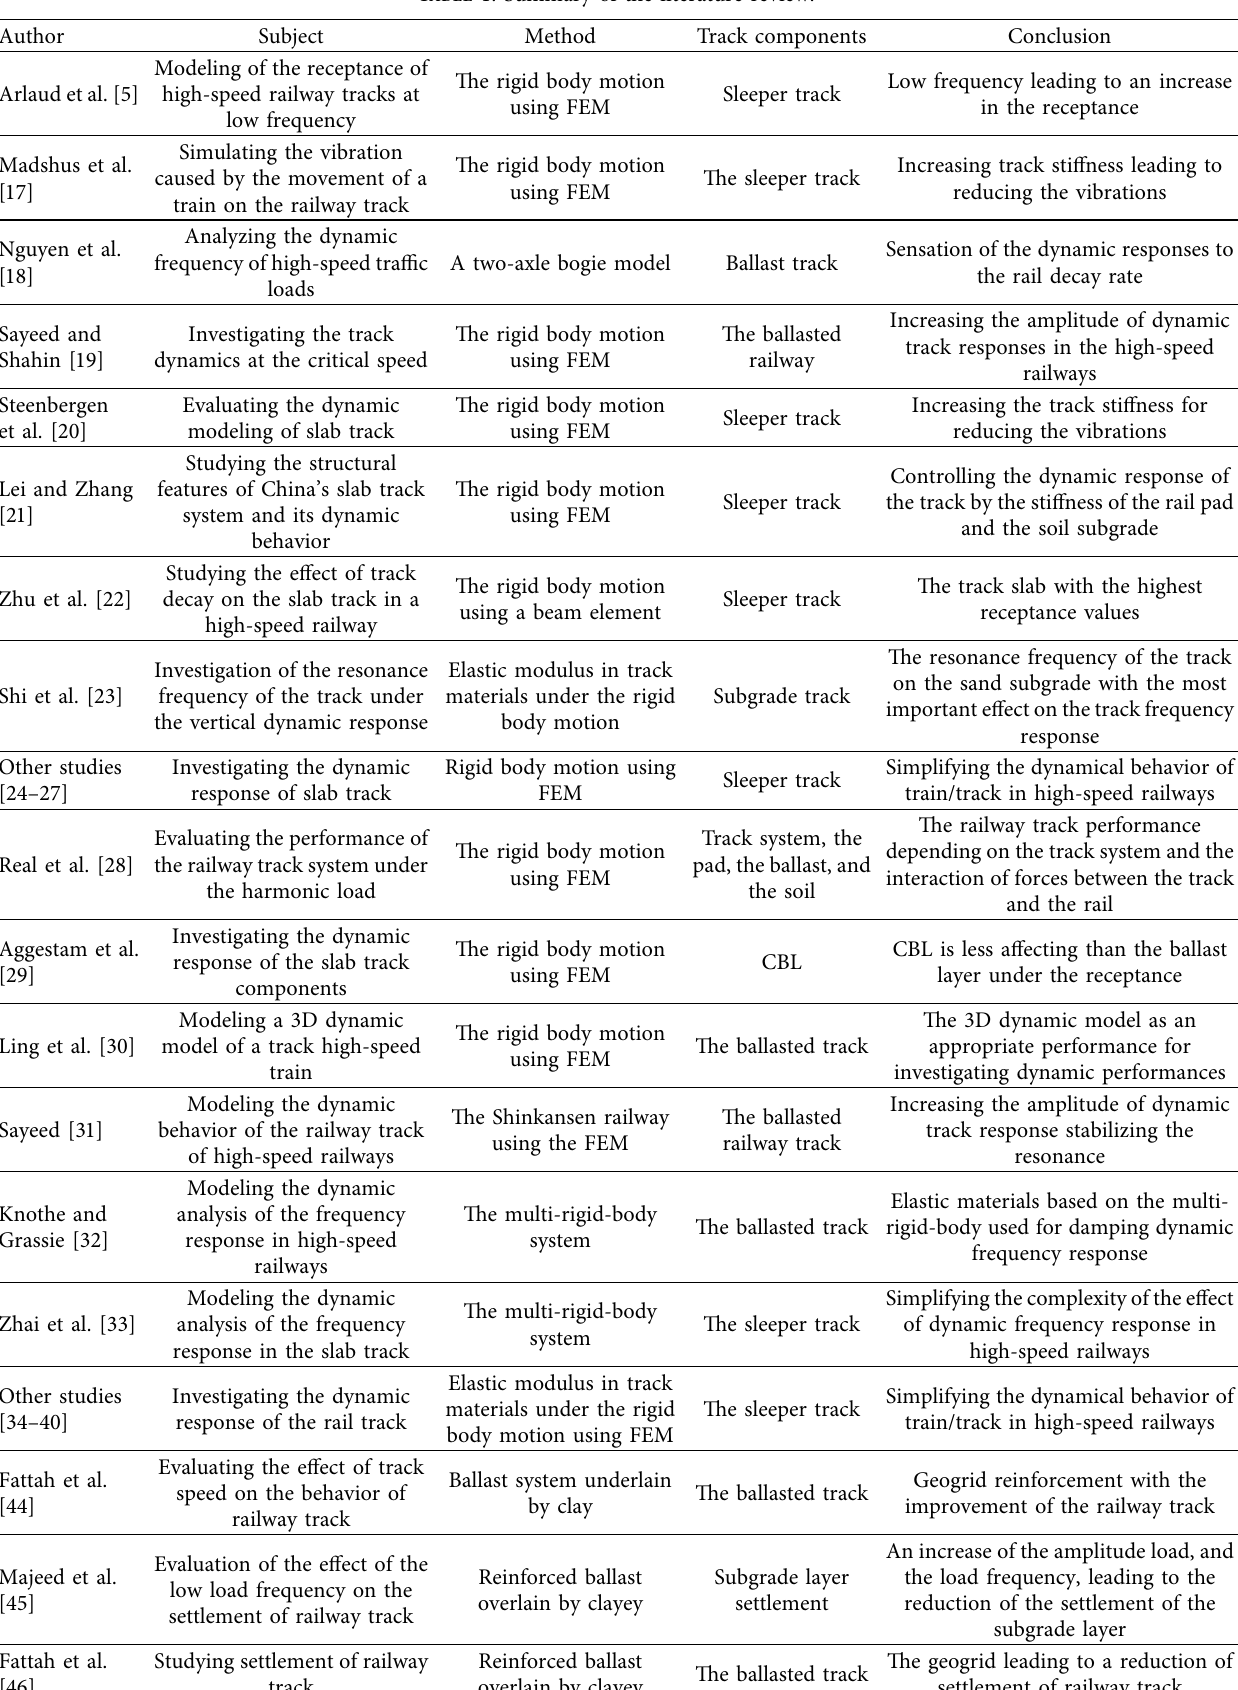
Table 1: Summary of the literature